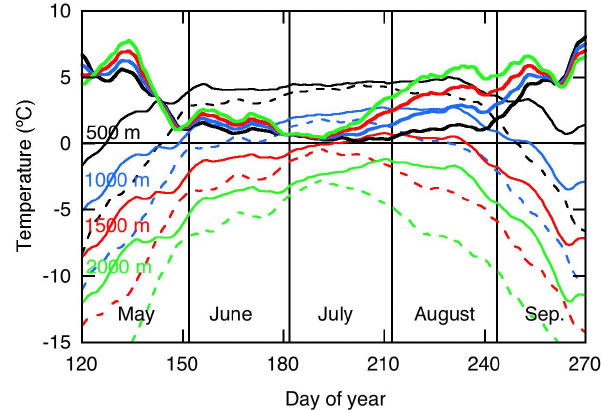
Fig. 3. Thirty-day running average of near-surface air temperature over the ice sheet at 500m (black), 1000m (blue), 1500m (red) and 2000m (green) elevation above sea level for 2009 (dashed lines) and 2010 (solid lines). Thick lines illustrate the 2010–2009 difference with the same colour